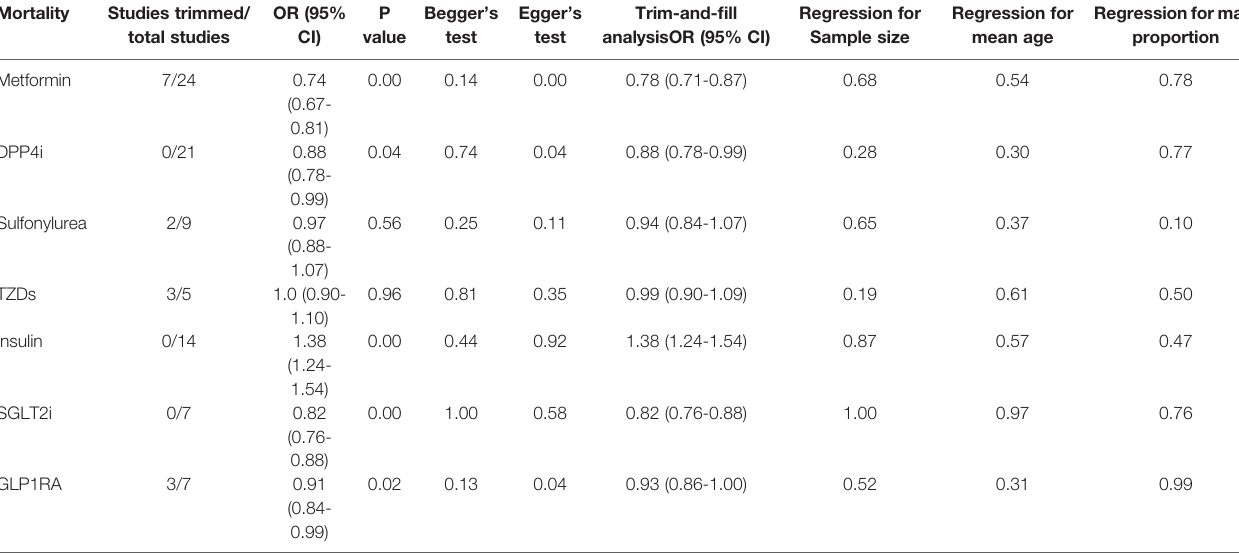
TABLE 2 | The results of publication bias and regression analysis for mortality.